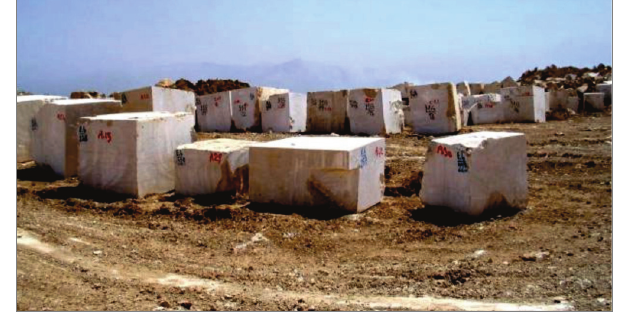
Fig. 2. Typical stone blocks